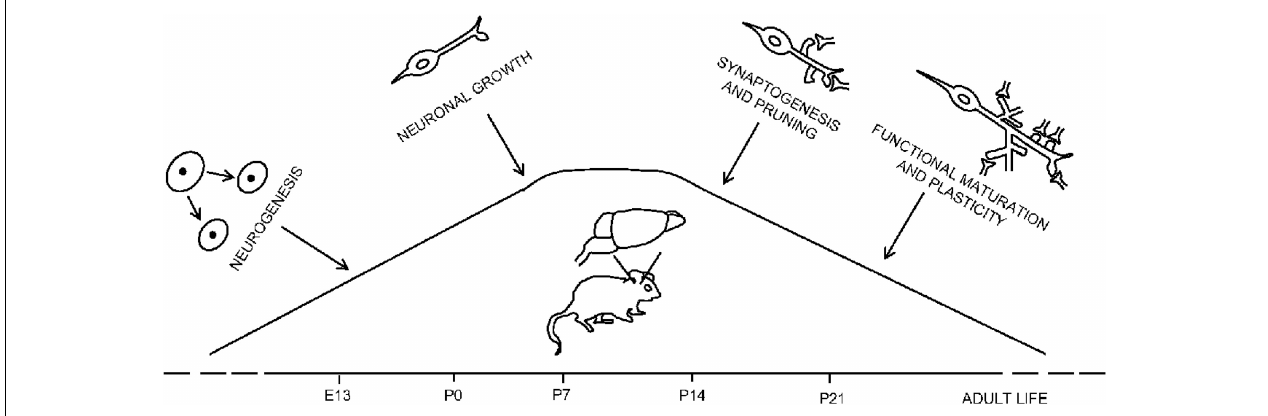
FIGURE 2 | Temporal and spatial regulation of MET levels in the mouse brain. MET expression increases during the perinatal period and peaks in correspondence of the processes of neurite growth and synaptogenesis (P7–P14) to decrease when brain circuits go through maturation and synaptic plasticity